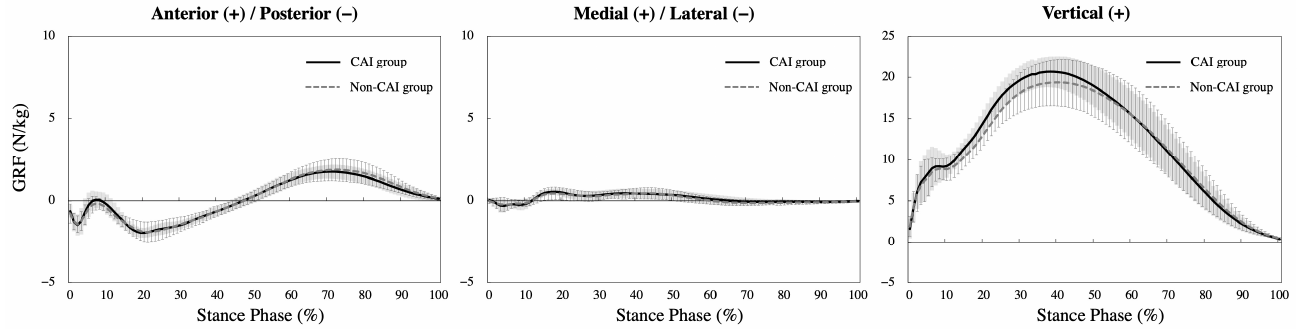
ing the stance phase of running. the stance phase of running.